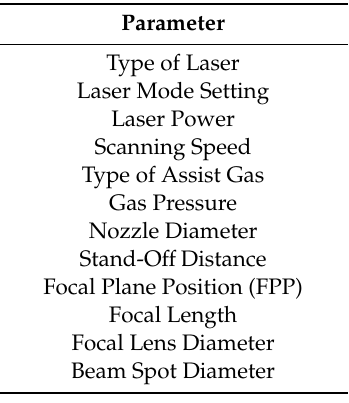
Table 1. Critical laser machining parameters.